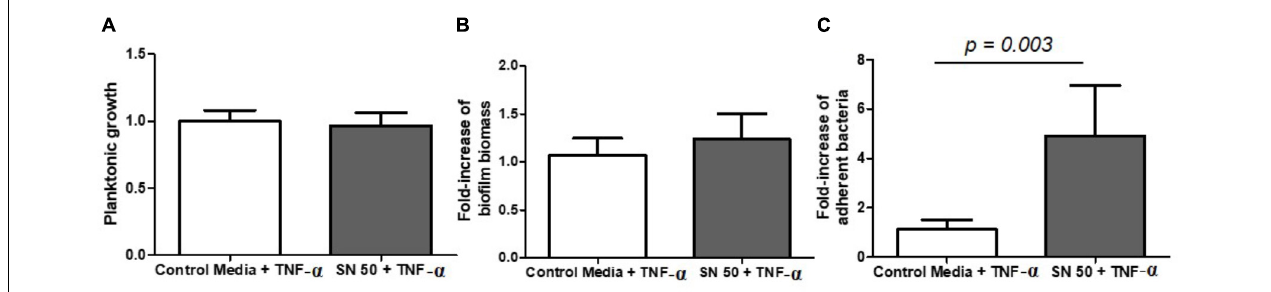
FIGURE 6 | Diluted supernatants of osteoblast culture stimulated with TNF- α influenced S. aureus biofilm formation. Planktonic growth normalized on control (A) fold-increase of biomass biofilm quantified by crystal violet staining (B) and fold-increase of live adhered cells (C) . Control medium + TNF- α = 50% DMEM,